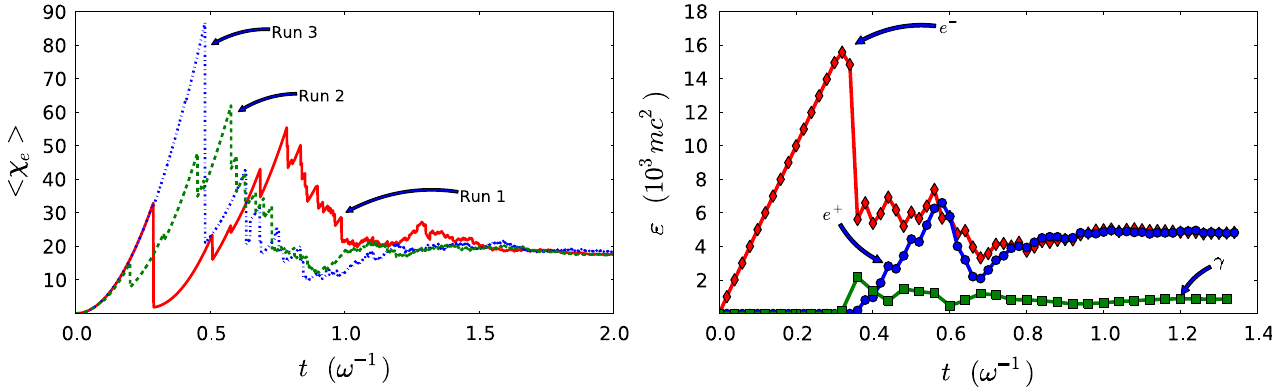
FIG. 5. Left plot: The dynamical quantum parameter h (cid:5) e i for the electrons averaged over the cascade vs time for the same simulations as in Fig. 4. Right plot: Evolution of the mean energy of the electrons, positrons, and photons averaged over the cascade in a typical simulation run ( a 0 ¼ 5 (cid:1) 10 4 and @ ! ¼ 1 eV